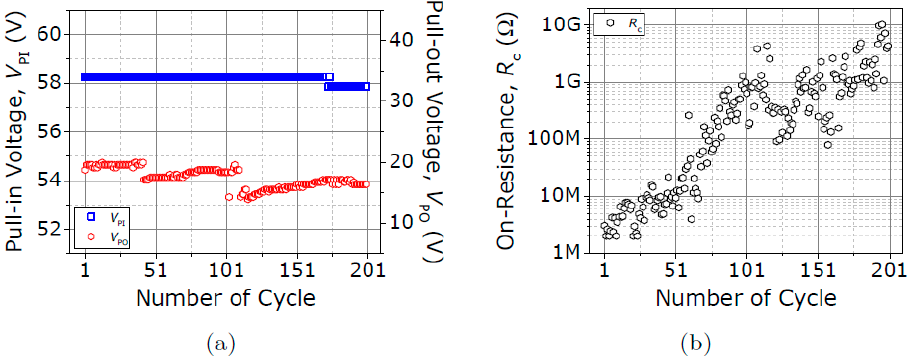
Figure 10. Evolution of ( a ) V PI , V PO and ( b ) R c over 200 switching cycles under vacuum conditions and V DS fixed at 3 V. Compliance current limit is fixed to 1 μ A.